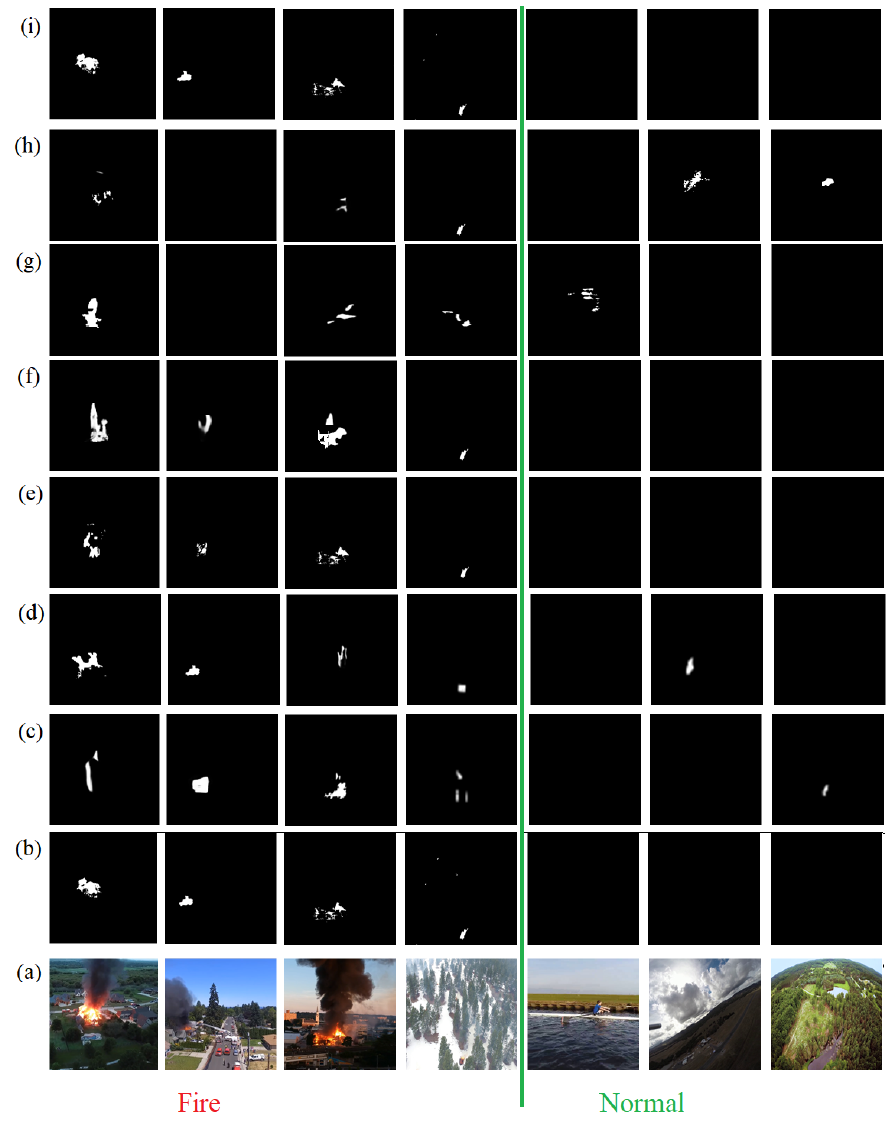
Figure 10. Qualitative comparison of the fire segmentation. From left: ( a ) first four are fire examples and the rest are normal, ( b ) corresponding ground-truth mask, and predicted masks by ( c ) Tran- sUNet, ( d ) Swin-UNet, ( e ) STNet+DenseFire, ( f ) SegFormer, ( g ) Deeplabv3+ResNet50, ( h ) UNet, and ( i )